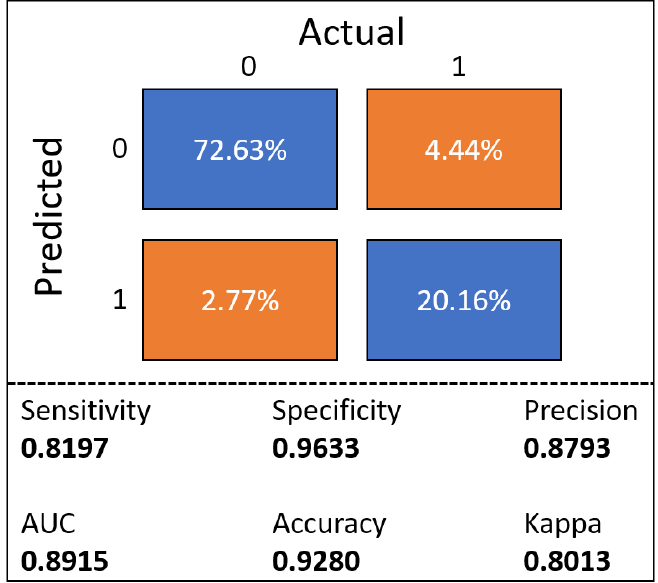
Figure 8. Convolutional neural network (CNN) confusion matrix for the training